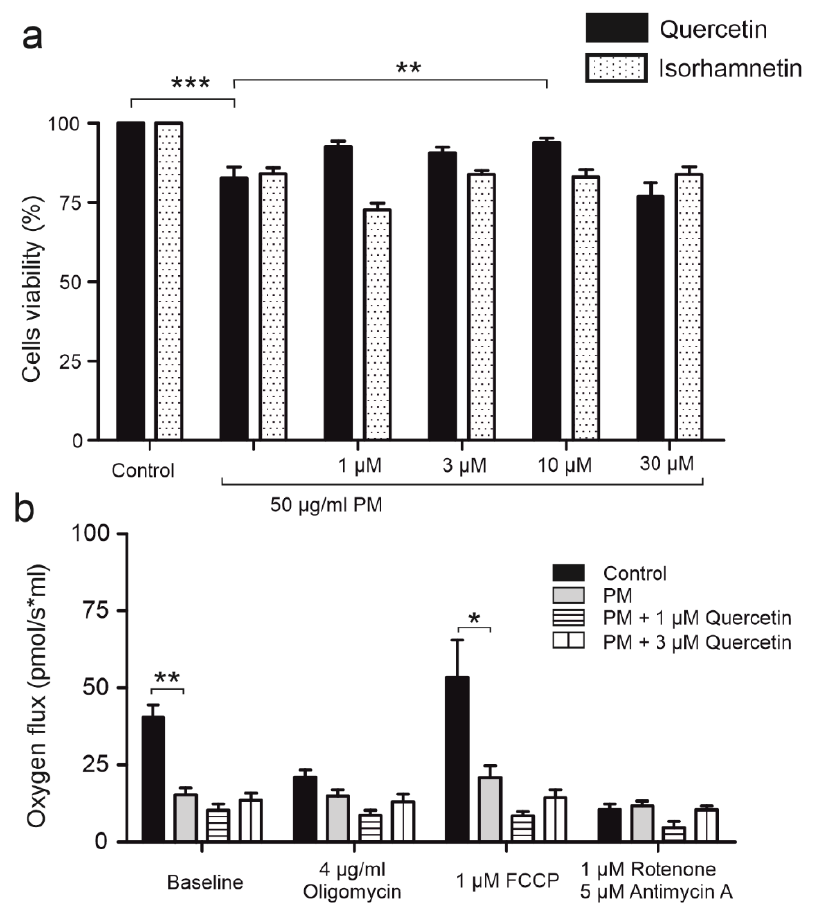
Figure 7. Effect of PM, quercetin, and isorhamnetin on HBE cell’s viability and mitochondrial function. ( a ) The bars represent the effect of 50 µ g/mL PM and quercetin (1, 3, 10, and 30 µ M) on cell viability measured using Trypan blue staining. Cell viability was measured after 24 h incubation with testing compounds. The effect is compared to control viability of the untreated cells. ( b ) HBE cells were exposed to subsequently 4 µg/mL oligomycin, 1 µM FCCP, and 1 µM rotenone with 5 µM antimycin A to measure mitochondrial dysfunction in control cells (black bars), cells incubated 24 h with 50 µg/mL PM (gray bars), cells incubated 24 h with 50 µg/mL PM and 1 µM quercetin (horizontal line bars), cells incubated 24 h with 50 µ g/mL PM and 3 µ M quercetin (vertical line bars). The results are represented by means ± SD, n = 3. Statistical significance was determined at p < 0.05 (*), p < 0.01 (**), p < 0.001 (***) by one-way